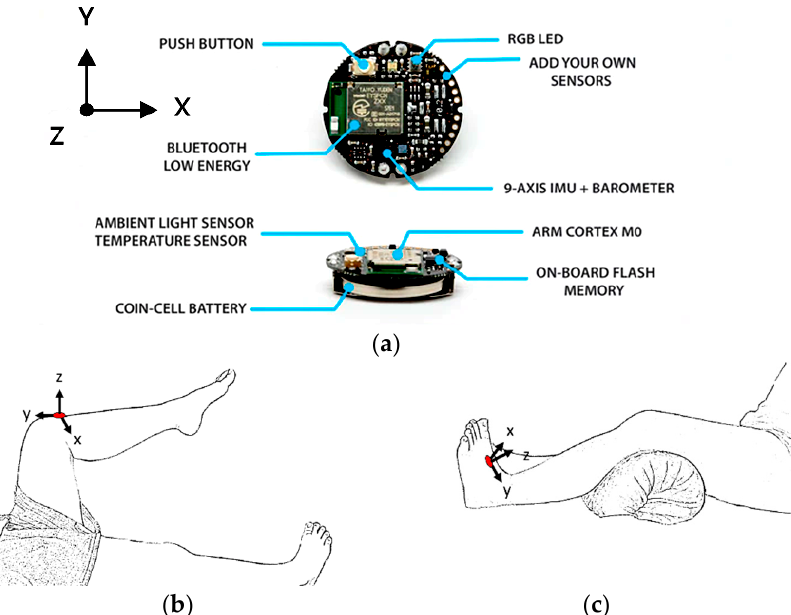
Figure 2. The MetaWearC sensor and positions ( a ) local coordinate for the device (https://mbientlab.com/metamotionc/ accessed on 10 July 2021), ( b ) position at the knee (Ex. 1-4) and ( c ) position at the foot (Ex. 5-6)